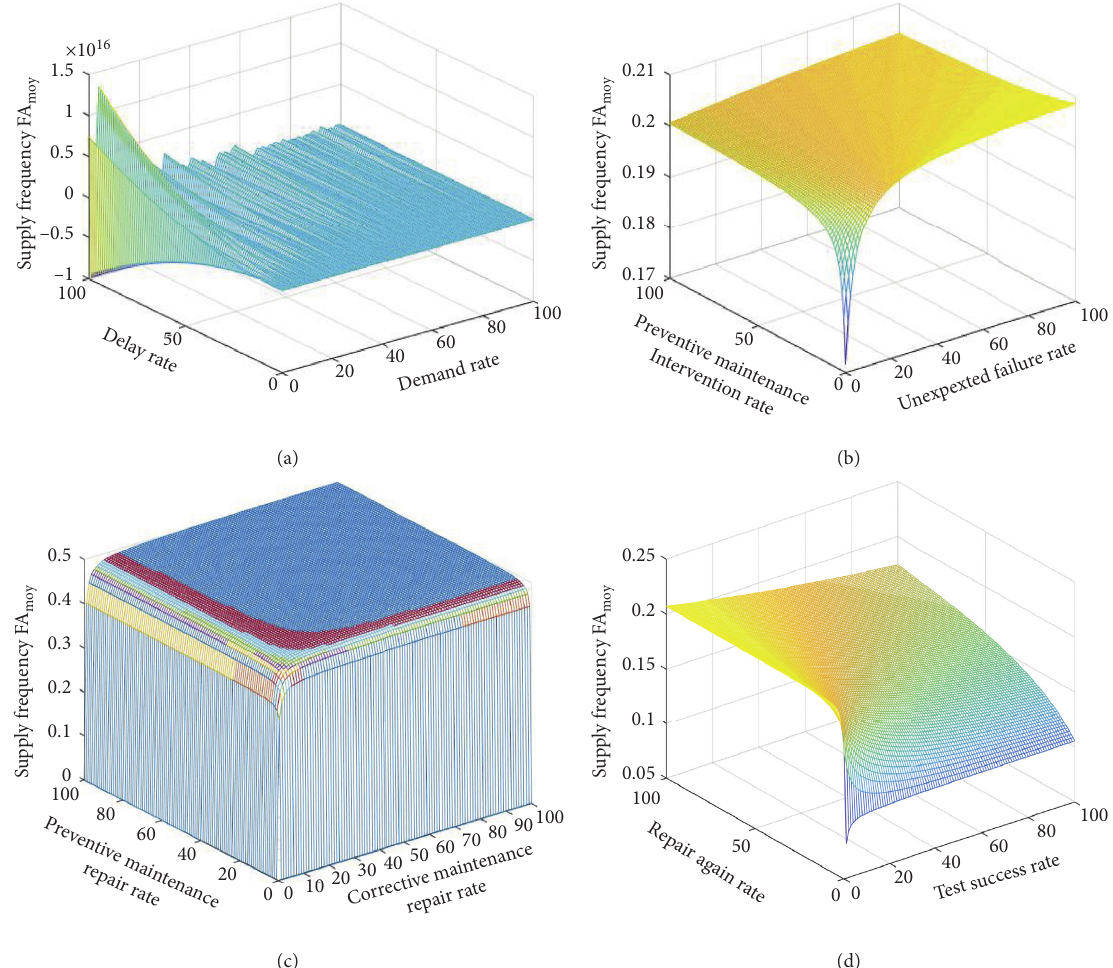
Figure 5: Supply frequency. (a) Variation of demand and delay rates. (b) Rate variation of unexpected failure and maintenance inter- ventions. (c) Repair rate variation for corrective and preventive maintenance. (d) Test rate variation (repair again or